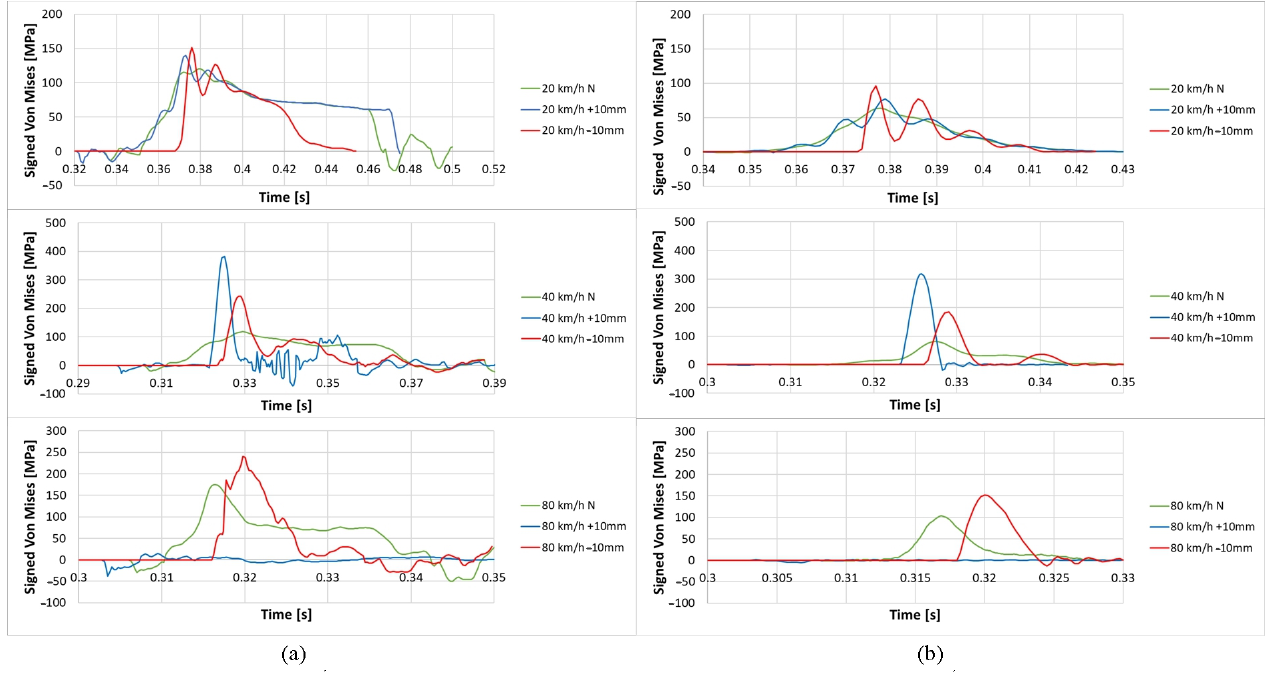
Figure 4. Simulation results (von Mises stress) for Critical Location 2. ( a ) Load scenario with the tire roll-over on two-thirds of the cover radius and two-point support; ( b ) load scenario with the tire roll-over on two-thirds of the cover radius and full